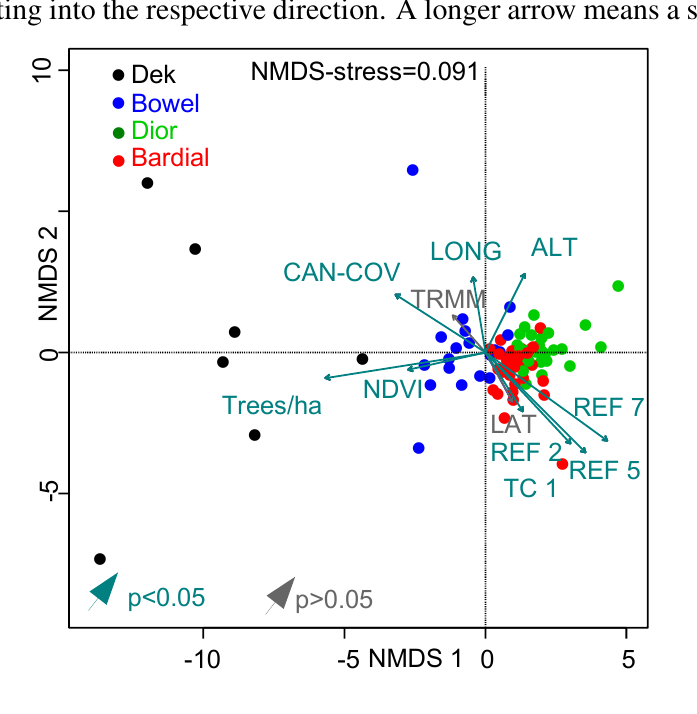
Figure 4. NMDS-ordination with grouped test sites (according to 28 soil parameters) and fitted